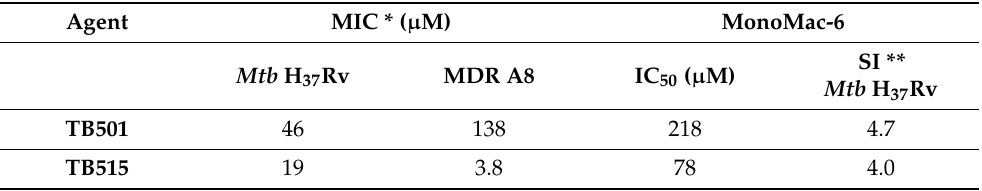
Table 5. The Minimum Inhibitory Concentration (MIC) of TB501 and TB515 agents on Mtb H 37 Rv and MDR A8 cultures. IC 50 and SI values on MonoMac-6 cultures infected with Mtb H 37 Rv. Agent MIC * ( µ